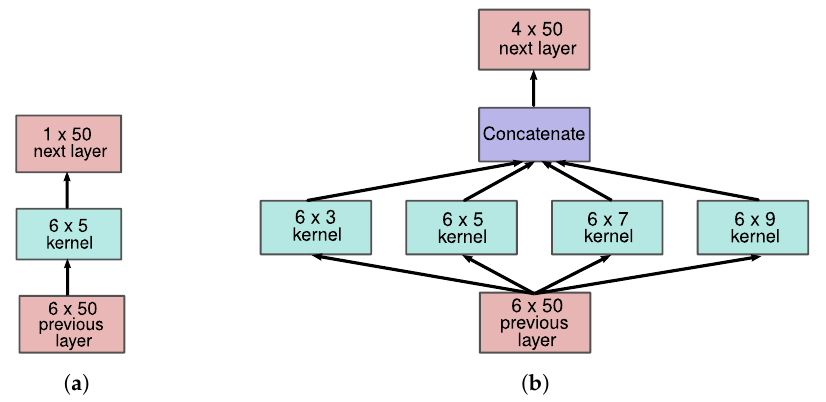
Figure 4. This figure illustrates a single layer in a standard CNN ( a ) and a multi-resolution CNN ( b ).